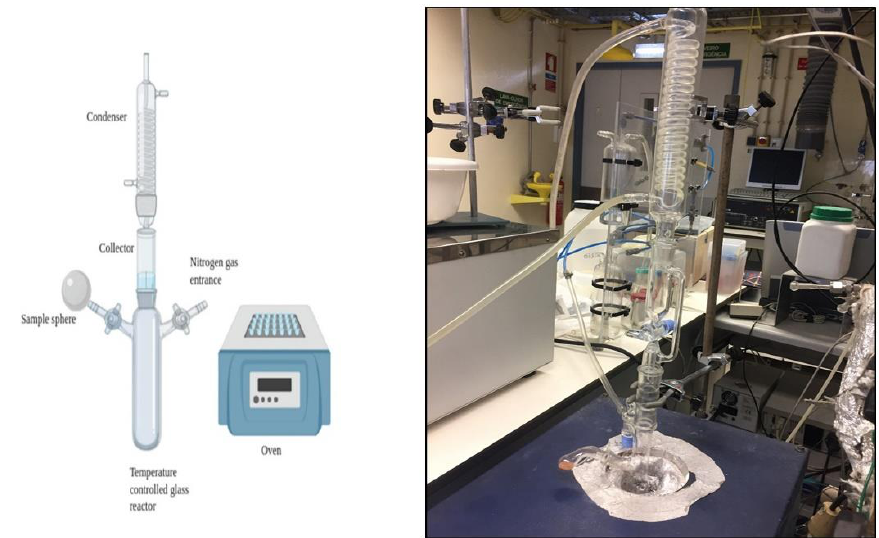
Figure 1. Schematics (on the left) of the Schlenk-type reactor used in the pyrolysis experiments (the figure was created with BioRender, www.biorender.com) (on the left), and photo (on the right) of the reactor before the sample introduction.